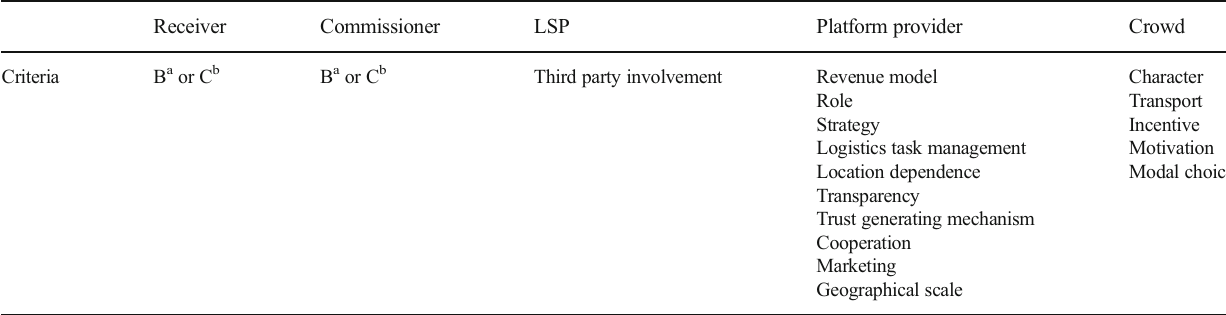
Crowd logistics